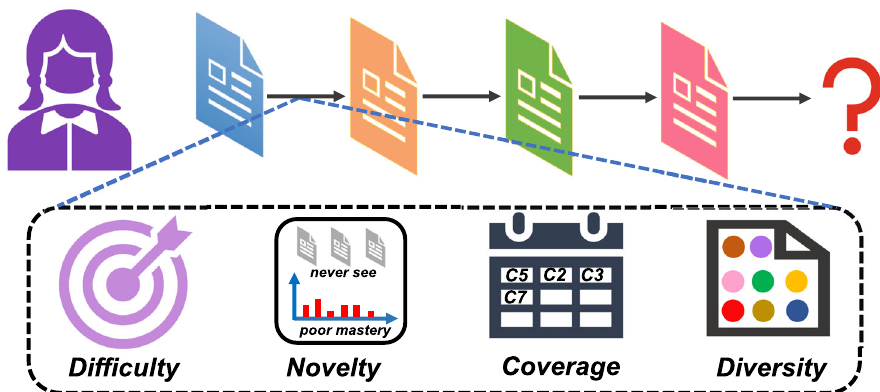
Fig. 1 An illustration of multi-objective recommendation